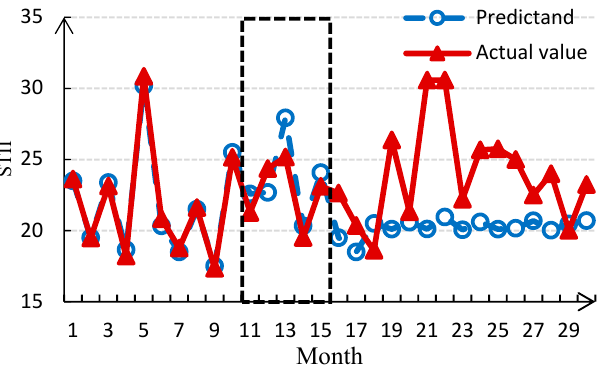
Figure 9. Test experiment of predictable time with different inputting data. (The effective predictions are highlighted with dotted line).